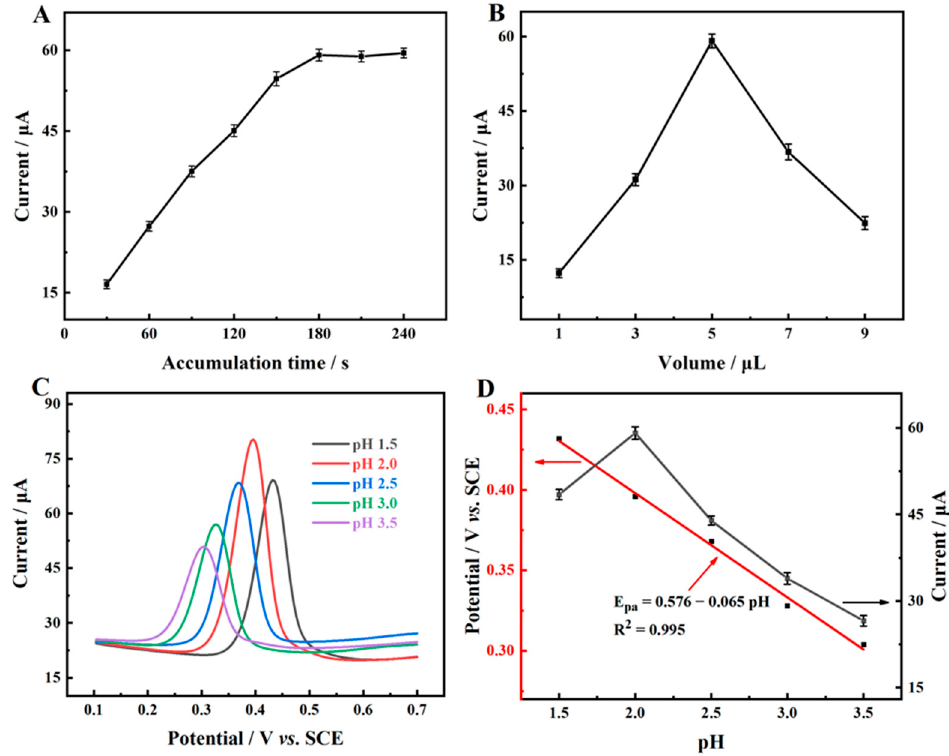
Figure 6. ( A ) Effect of accumulation time on current response; ( B ) Effect of the volume of TiO 2 - Figure 6. ( A ) E ff ect of accumulation time on current response; ( B ) E ff ect of the volume of TiO 2 - MXene/PEDOT:PSS on current response; ( C ) DPV of 10.0 µ M baicalein determined by TiO 2 - MXene/PEDOT:PSS on current response; ( C ) DPV of 10 µM baicalein TiO 2 -MXene/PEDOT:PSS/GCE in PB (0.1 M) with di ff erent pH values; ( D ) E ff ect of pH value on the I pa and E pa . MXene/PEDOT:PSS/GCE in PB (0.1 M) with different pH values; ( D ) Effect of pH value on the I pa and E pa